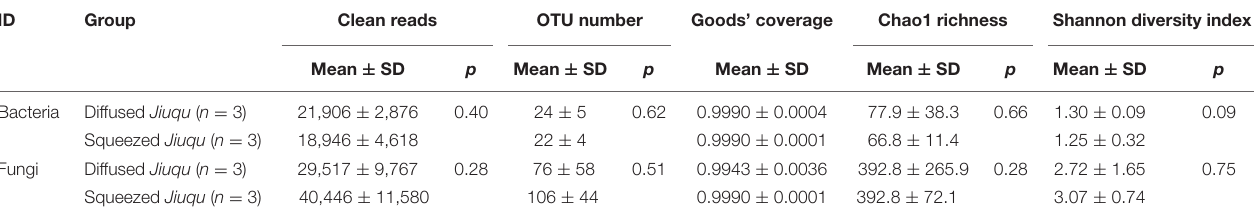
FIGURE 2 | Microbiota components analysis across all the samples. (A) The contents of bacteria, molds and yeasts were analyzed by RT-qPCR. (B) Amplicons analysis represented the similarities of microbial compositions based on principal component analysis (PCA). (C) The different microbiota content between diffused and squeezed Jiuqu represented in bacterial and fungal distribution. Compared to diffused Jiuqu , red and black asterisks denote statistically significant increase and decrease in squeezed Jiuqu (paired-sample t -test: ∗ , p < 0.05; ∗∗ , p < 0.01; ∗∗∗ , p < 0.001). TABLE 1 | Bacterial and fungal microbiota diversity index based on 16S rRNA and ITS amplicons sequencing across